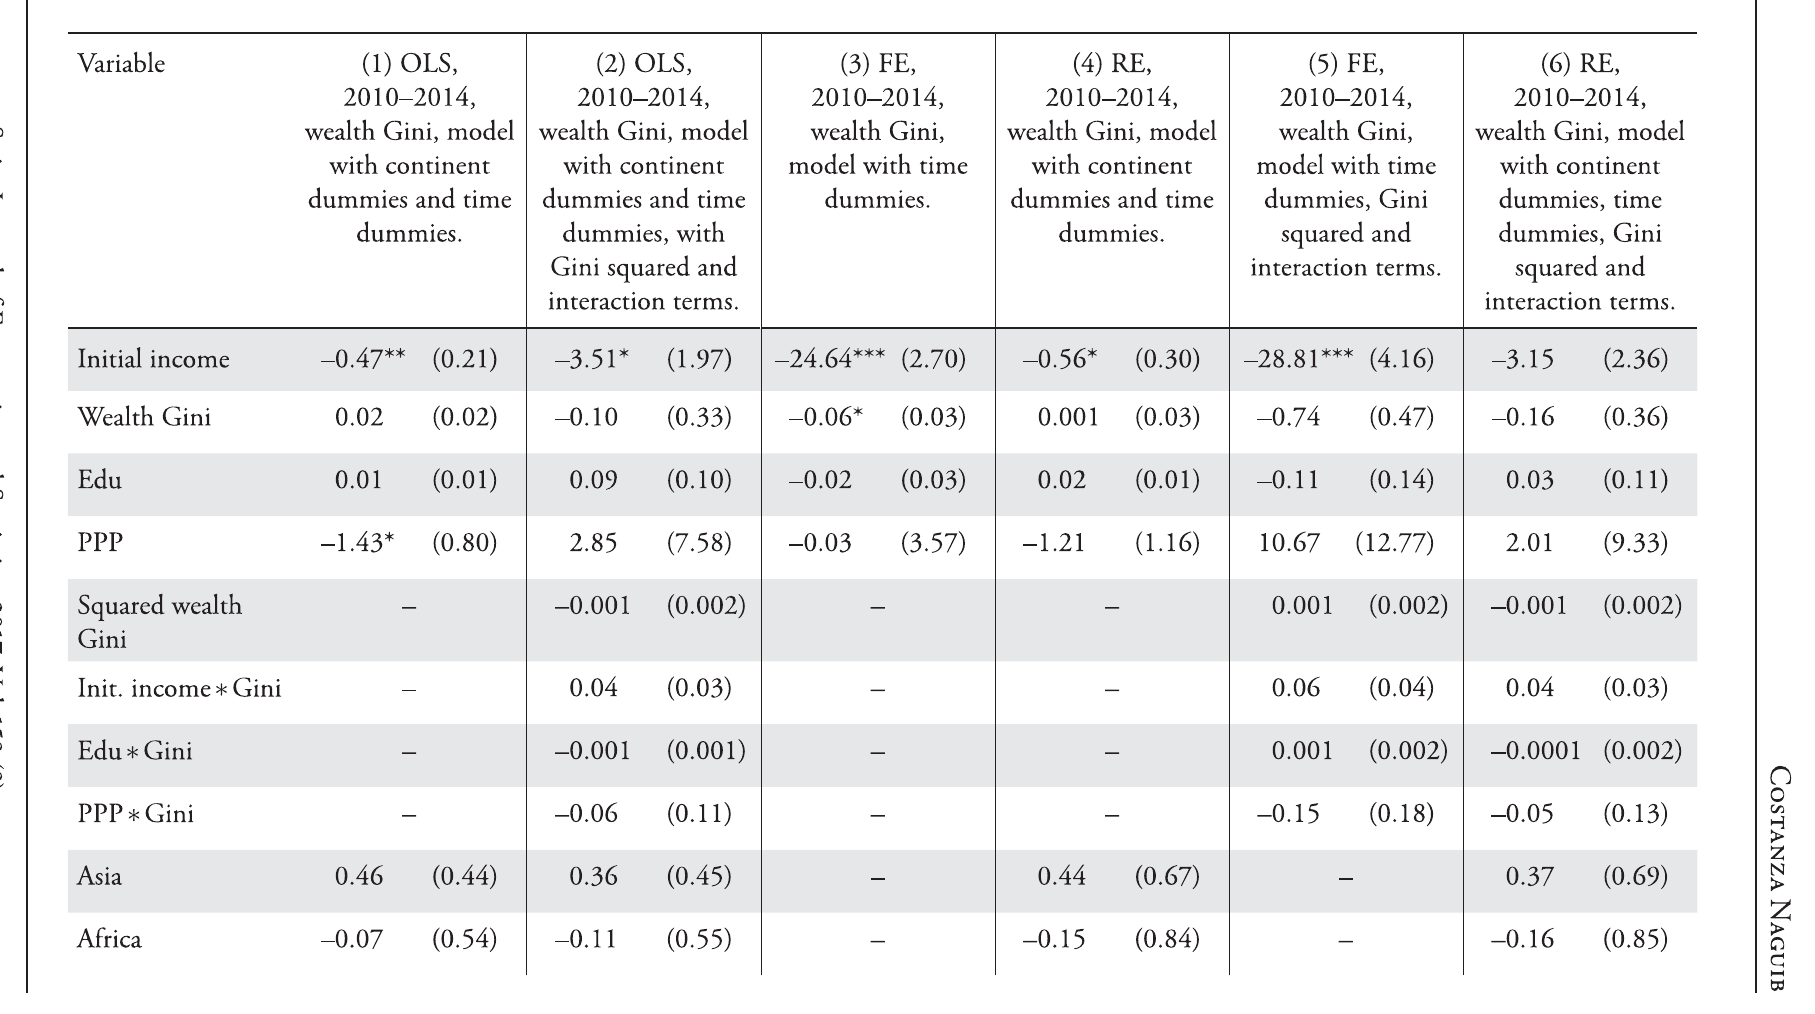
Table 5: Impact of Income and Wealth Gini on GOP Per Capita Growth OLS, FE andRE Estimates, 146 countries